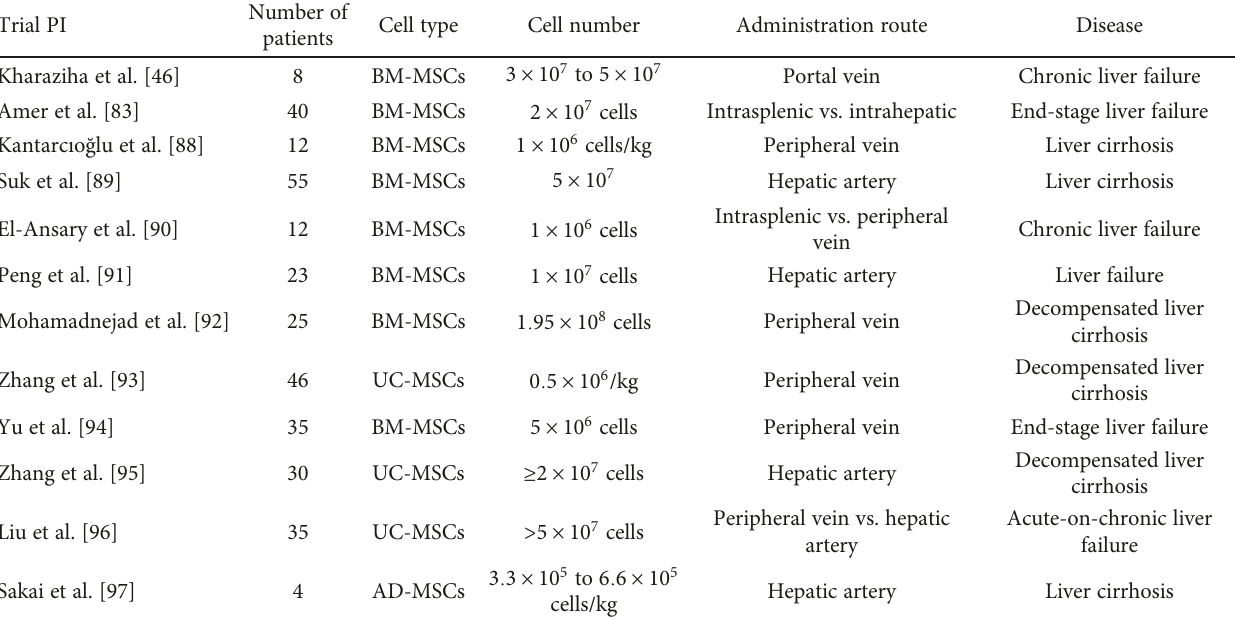
Table 2: Summary of clinical trials with MSC for liver